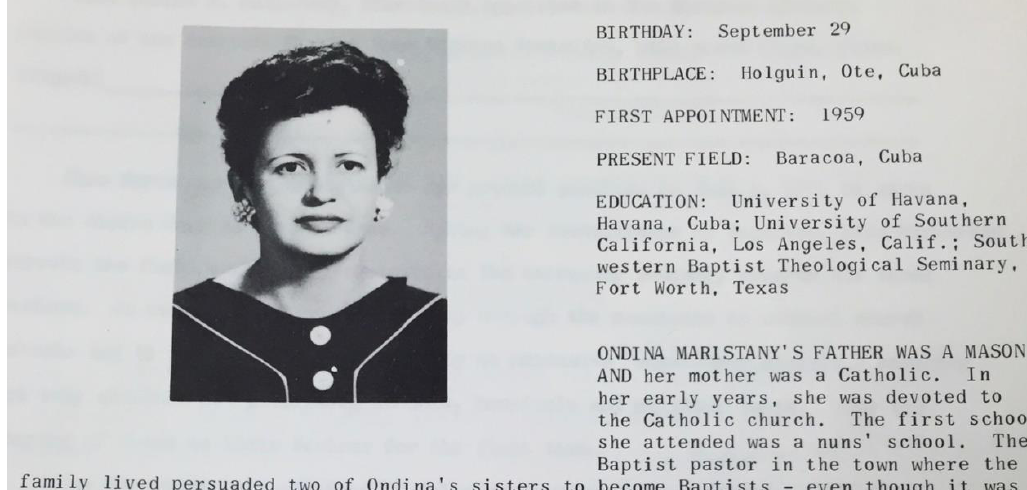
Figure 5. Ondina Maristany Cervantes. 66